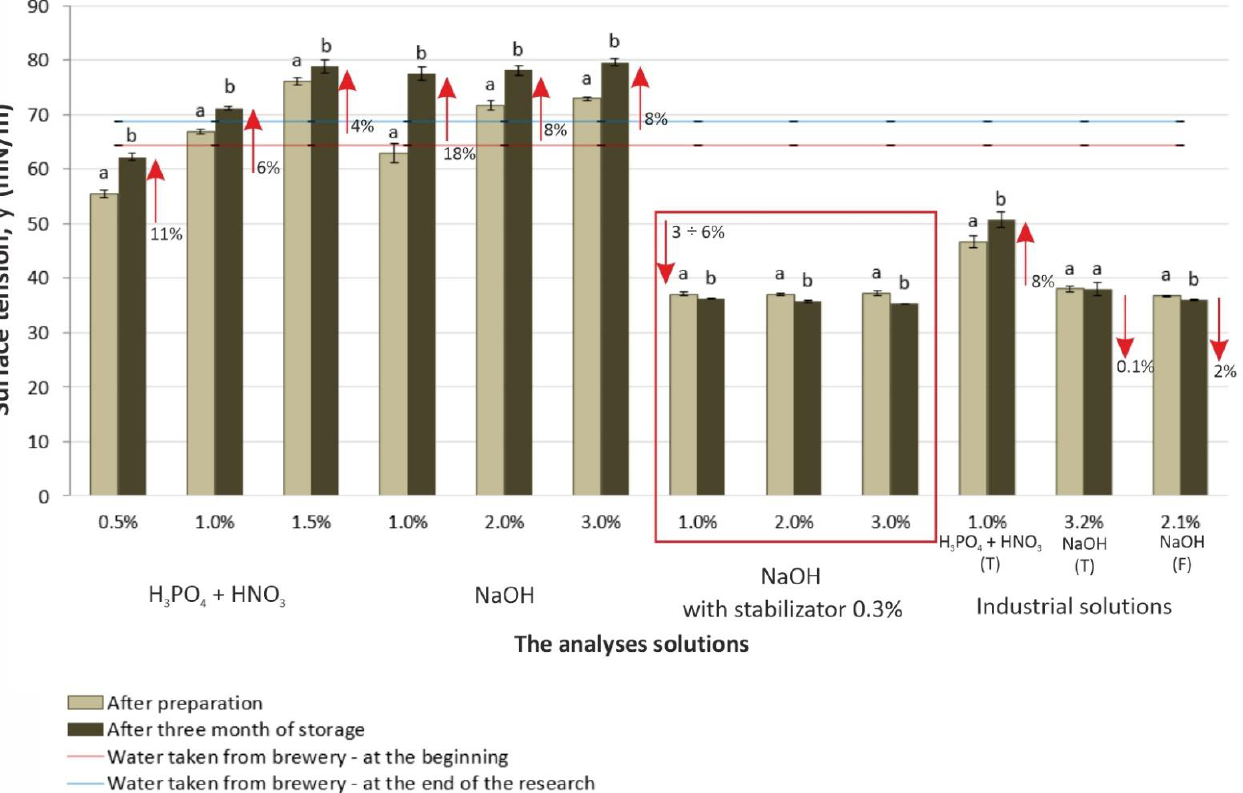
Figure 2. Changes in surface tension of the tested solutions during their storage ( a, b different letters in the same column indicate significant statistical difference Tukey’s HSD test, α = 0.05).